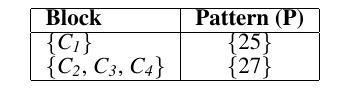
Table 1. Patterns Identification algorithm resulting PI matrix